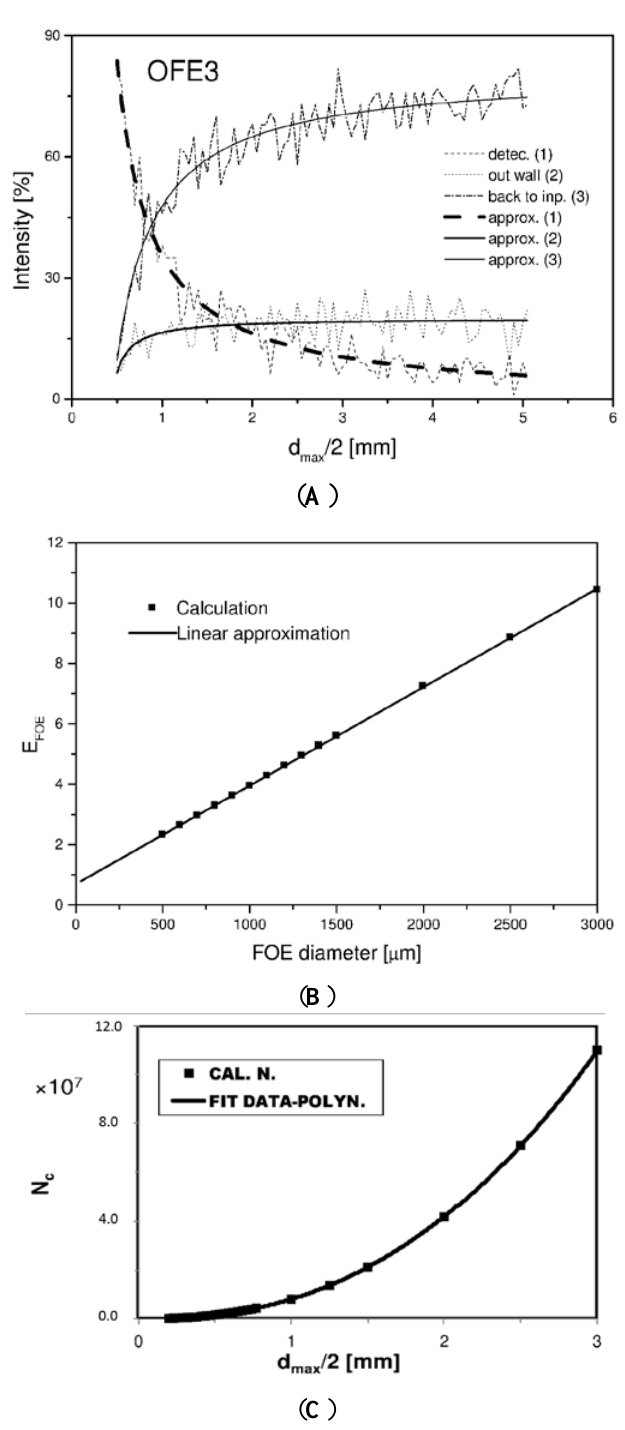
Figure 8. ( A ) Calculation of normalized intensity in % of ray traces by FOE 3- to detector, 2- out of wall and 1- back to impute; ( B ) Dependence of efficiency E FOE = T cal (d max ) , N c (d max ) ; T is calculated Transmission of FOE as a function of max. FOE radius; ( C ) Dependence of calculated numbers N C as a function of max. FOE radius